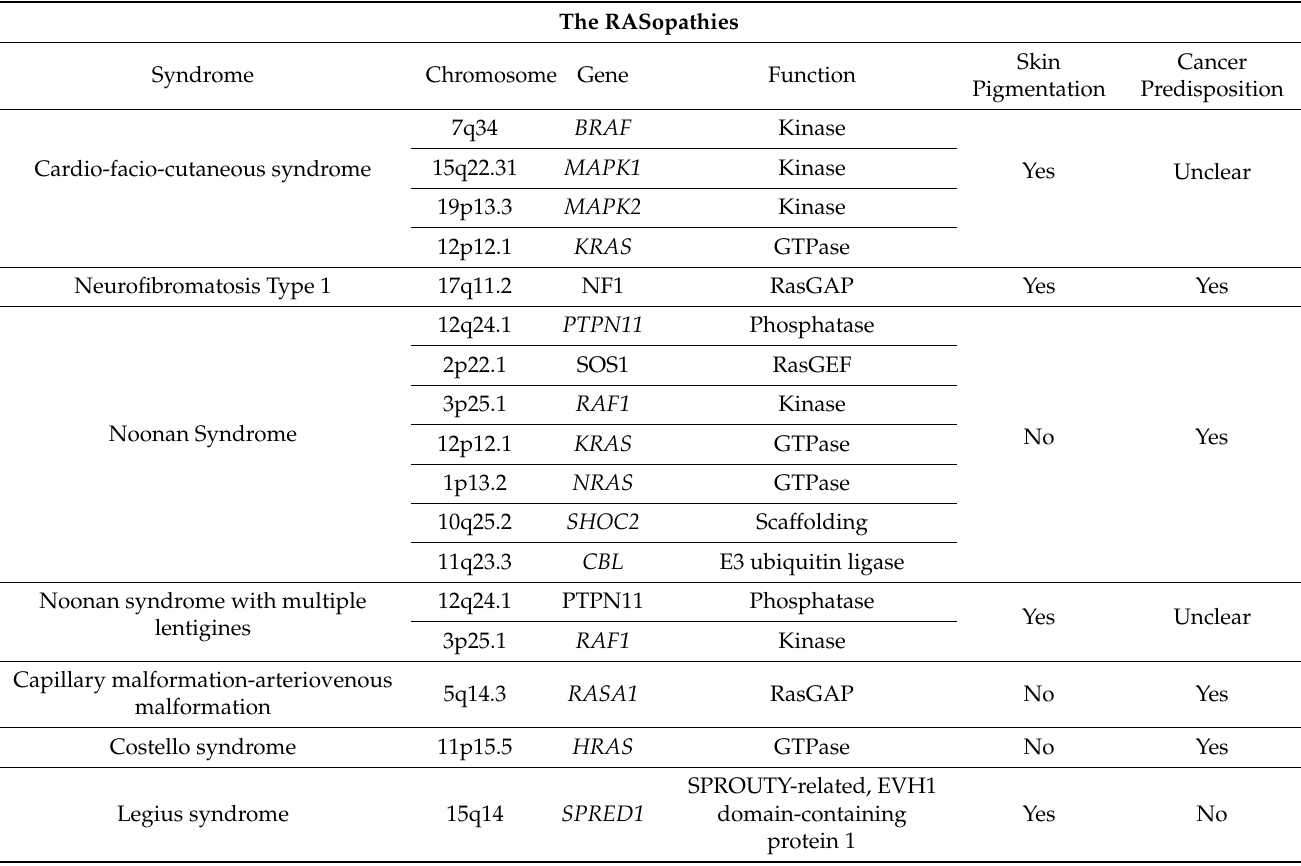
Gene symbols: Please refer to the outer